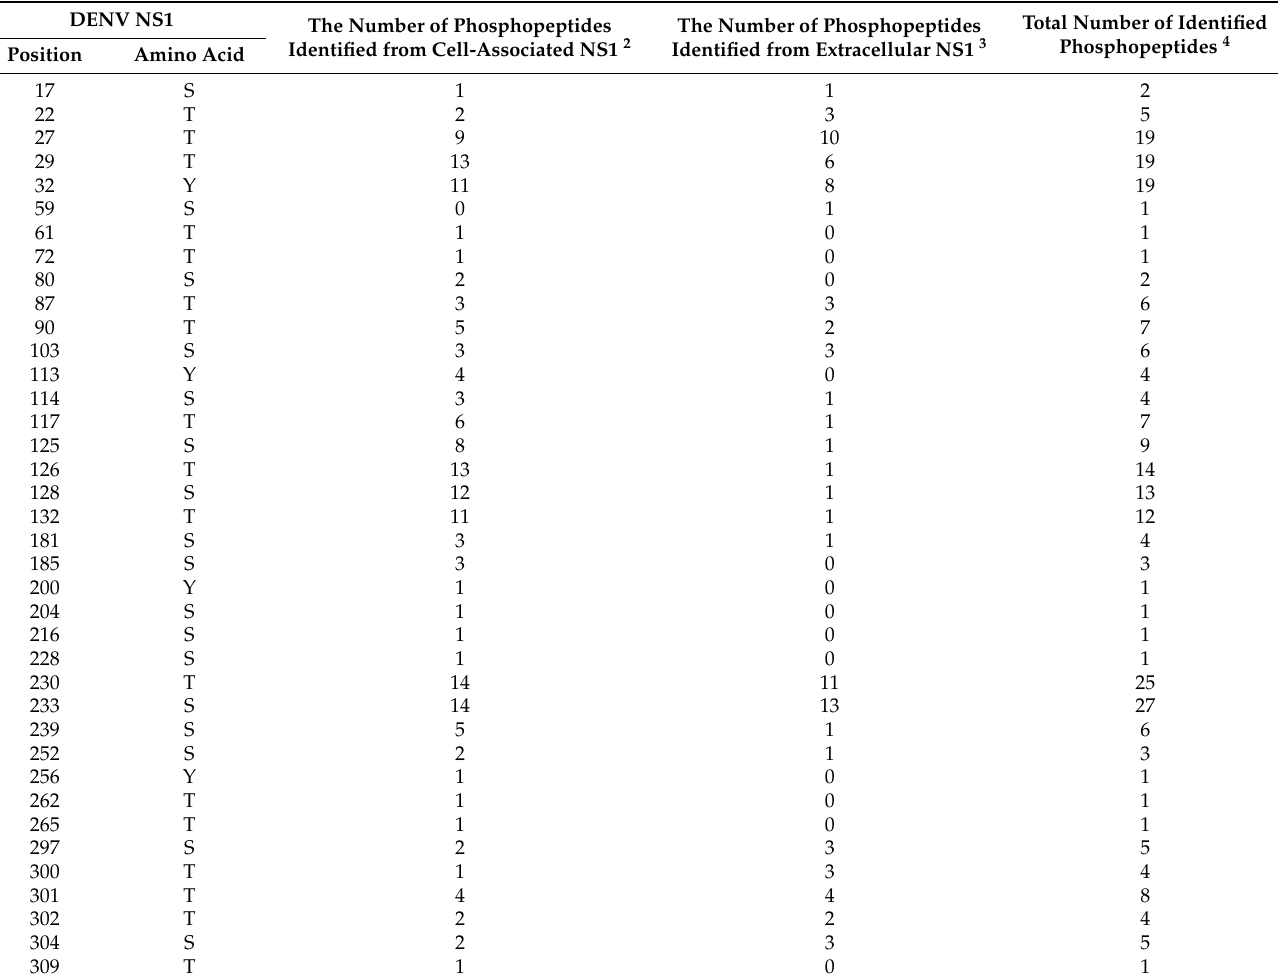
Table 2. Detection of potential phosphorylation sites at specific amino acid positions on cell-associated and extracellular NS1 proteins from three cell types 1